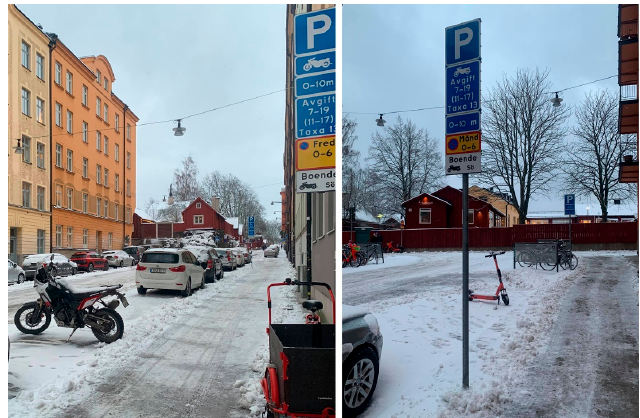
Figure 5. Examples of parking spaces for motorbikes in Stockholm. Source: Authors’ archives (photo D. Gunnarsson). In 2017, the city government increased parking fees for motorcyclists but with the onset of the pandemic, the decision was made to allow motorbike designated parking